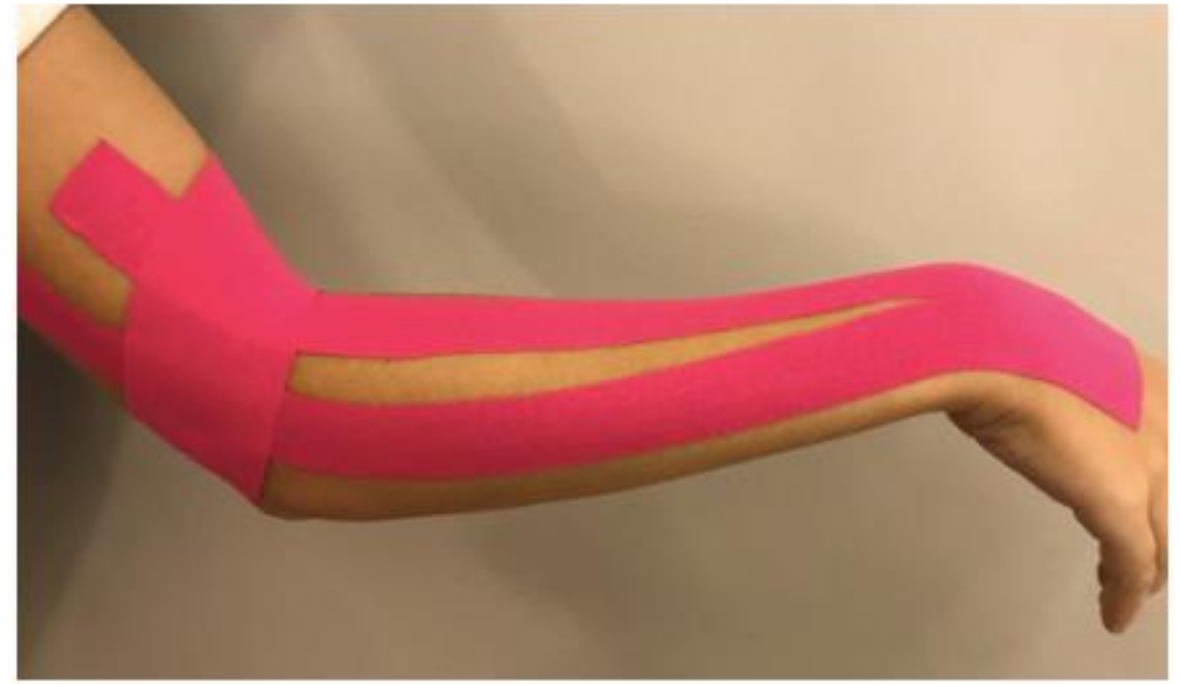
Figure 2. Muscle inhibition Kinesio tape (KT) applied from the origin to the insertion of the extensor muscle